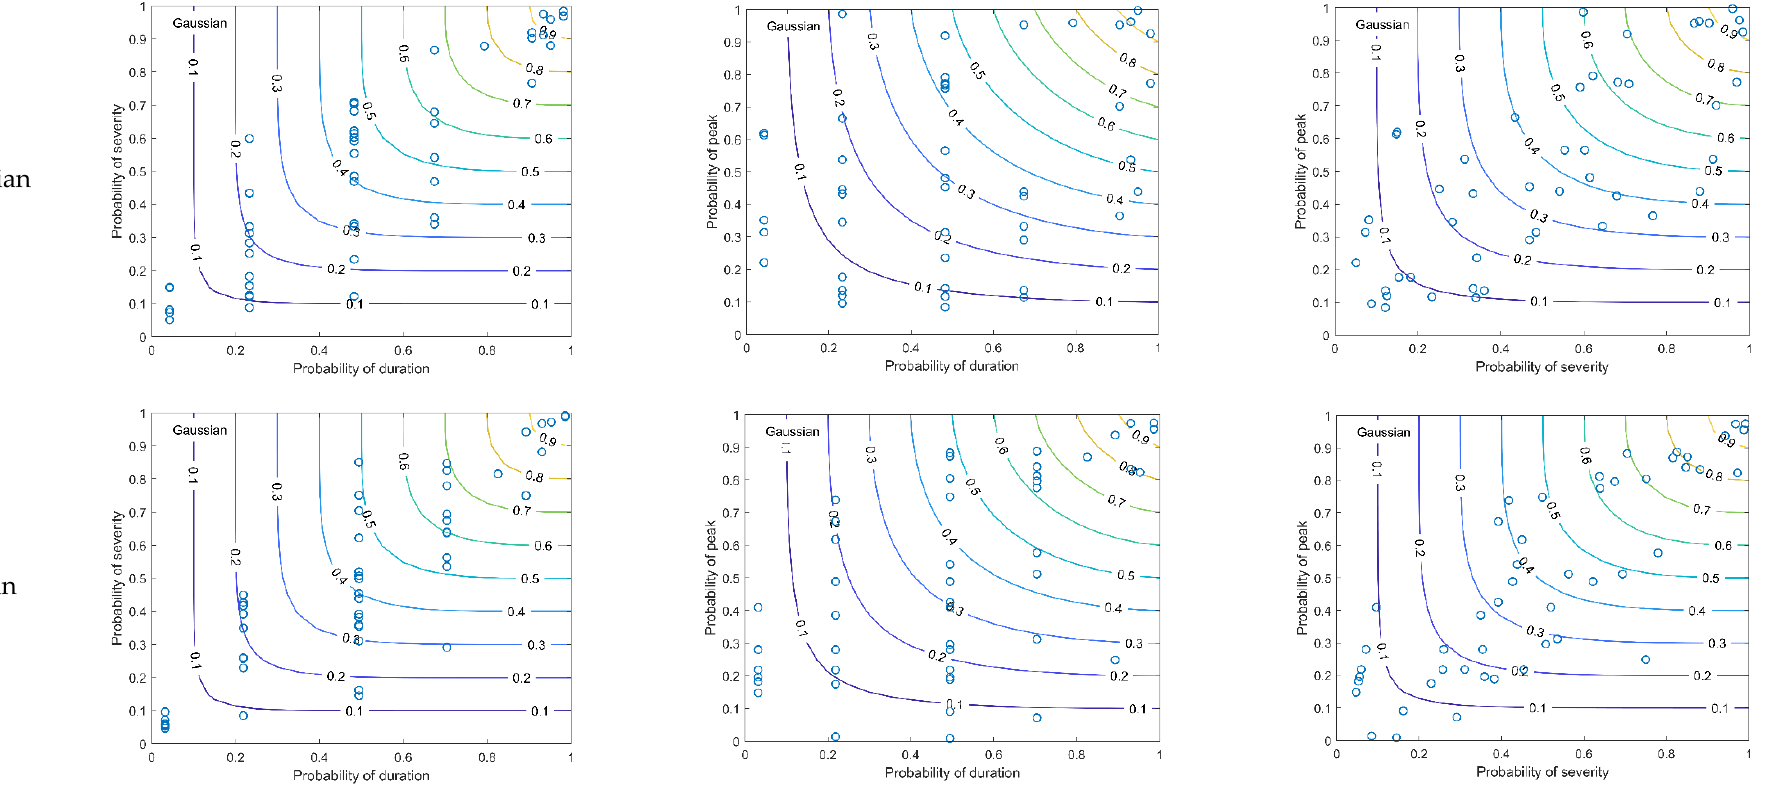
Figure 6. Data space and contour plots of joint probabilities of drought duration, severity and peak.